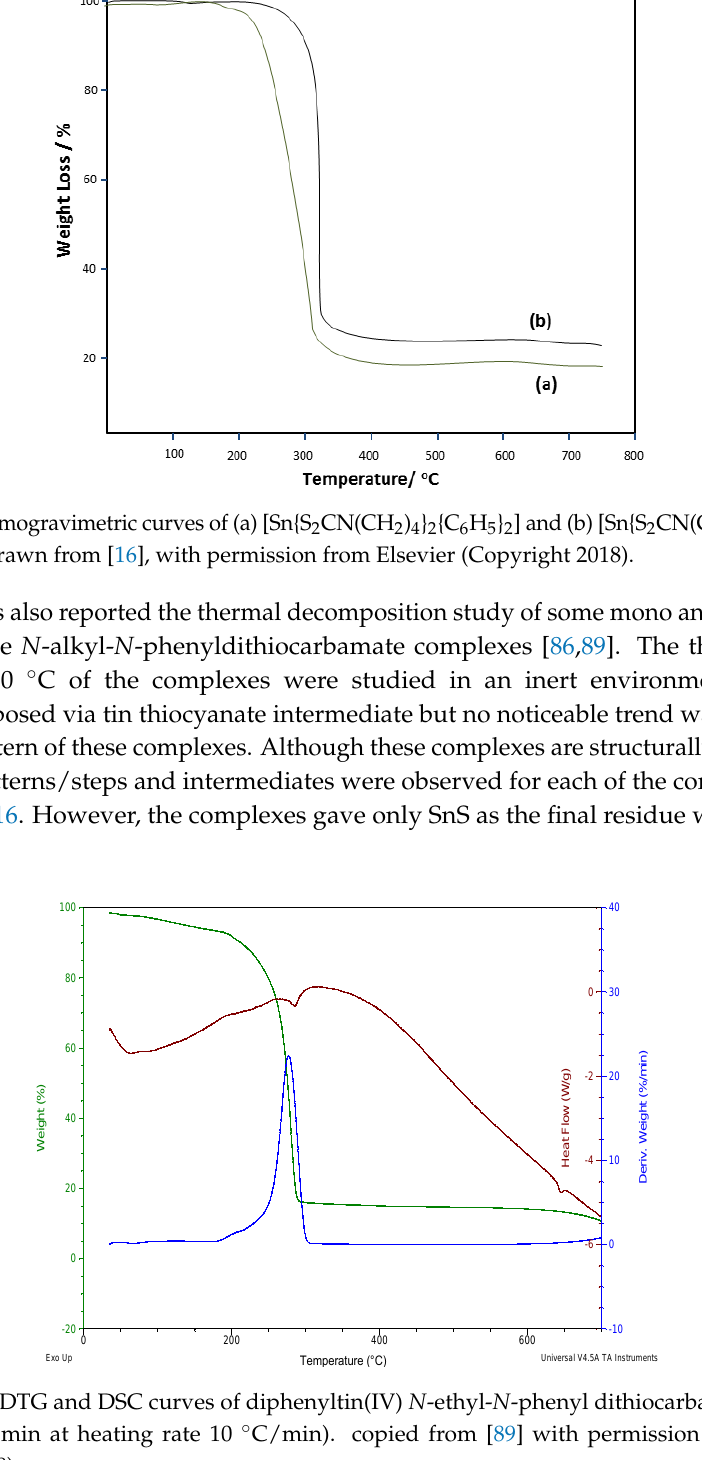
Figure 15. TG/DTG and DSC curves of diphenyltin(IV) N -ethyl- N -phenyl dithiocarbamateobtained in N 2 (75 mL/min at heating rate 10 °C/min). copied from [89] with permission from Elsevier (Copyright 2018).